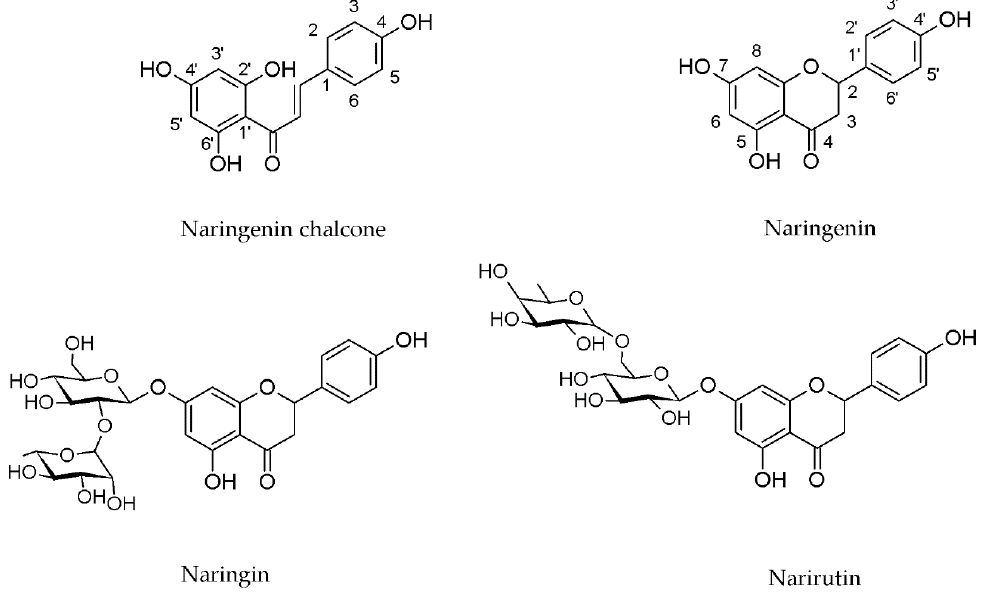
Figure 1. Structures of naringenin chalcone, naringenin, naringin and narirutin. 2. Content of Naringenin and its Glycosides in Plants and Products of Plant Origin